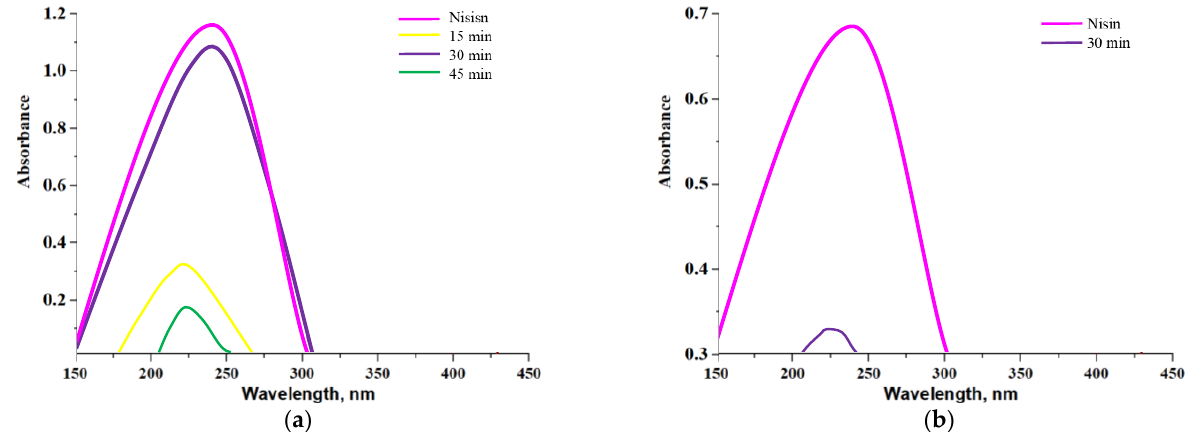
Figure 14. UV-Vis spectra showing a nisin release from alginate-based capsules in an alkaline environment ( a ) and in acidic environment ( b ).